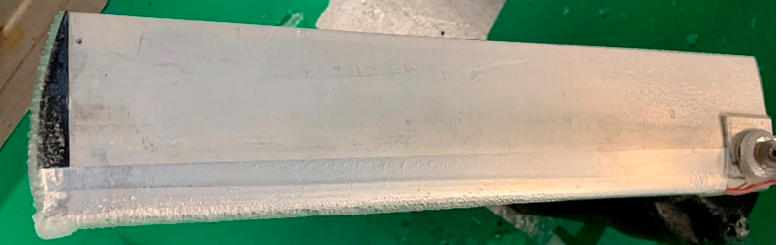
Figure 11. Pictures of the runback free blade (only ice accretion on the leading edge) with Coating 4.